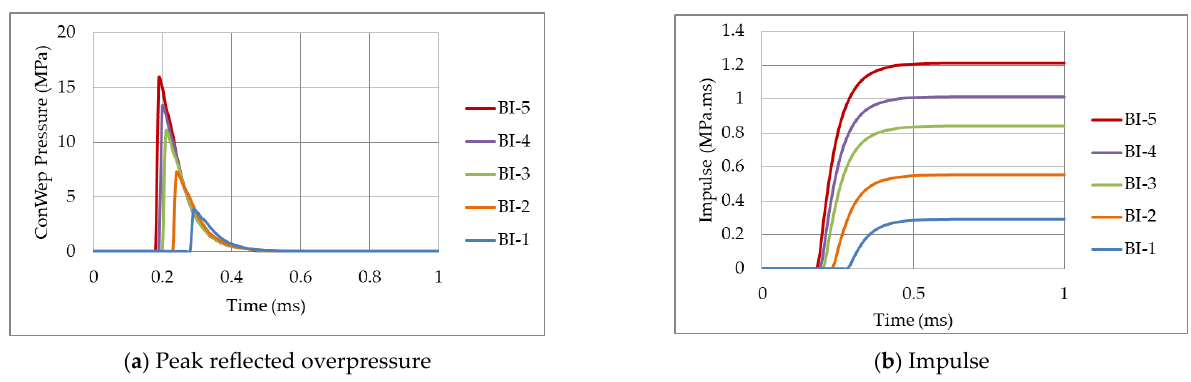
Figure 4. ConWep “peak reflected overpressure” and “reflected impulse” time histories of the selected M-R combinations in this paper (0.1–0.5 kg of TNT at R = 0.5, listed in Table 2). ( a ) Peak reflected overpressure; ( b ) Impulse.